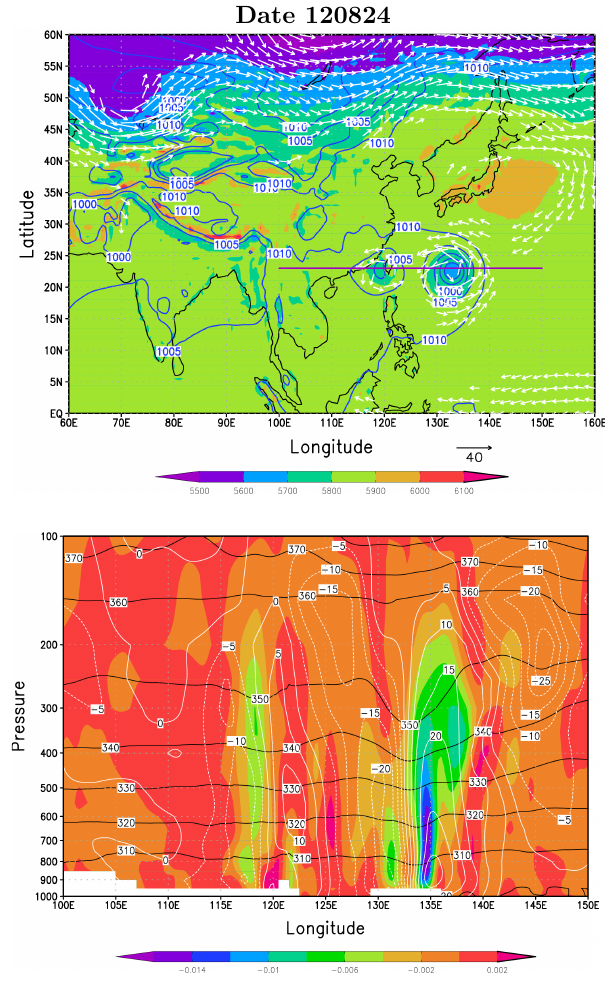
Figure 5. Geopotential height [m] (colour) and horizontal winds [ms − 1 ] (white arrows) at 500hPa on 24 August 2012 taken from ERA-Interim reanalysis data (top). To show the position of the ty- phoons Tembin ( ≈ 23 ◦ N 118 ◦ E) and Bolaven ( ≈ 23 ◦ N 135 ◦ E), the mean sea level pressure [hPa] is shown as blue thick lines. Fig. 5. Geopotential height in [m] (colour) and horizontal winds in [ ms − 1 ] (white arrows) at 500hPa on 24 August 2012 taken from ERA- The thick purple line indicates the position of the longitude–height Interim reanalysis data (top). To show the position of the typhoons Tembin ( 23 ◦ N 118 ◦ E) and Bolaven ( 23 ◦ N 135 ◦ E), the mean sea cross-section shown in Fig. 5 (bottom). Longitude–height cross- ≈ ≈ level pressure in [hPa] is shown as blue thick lines. The thick purple line indicates the position of the longitude-height cross-section shown section showing the typhoon Tembin and Bolaven at 23 ◦ N (bot- in Fig. 5 (bottom). tom). The vertical velocity ( ω ) [hPas − 1 ] (colour), the horizon- Longitude-height cross-section showing the typhoon Tembin and Bolaven at 23 ◦ N (bottom). The vertical velocity ( ω ) in [ hPas − 1 ] (colour), tal winds [ms − 1 ] (white line (positive values) and white dashed the horizontal winds in [ ms − 1 ] (white line (positive values) and white dashed line (negative values)), and potential temperature in Kelvin (black lines) are shown. Very rapid uplift up to 0.014 hPas − 1 is found at the eastern flank of typhoon Bolaven ( line (negative values)), and potential temperature in Kelvin (black 135 ◦ E) and up to − ≈ 0.006 hPas − 1 is found at western flank of typhoon Tembin ( 118 ◦ E). lines) are shown. Very rapid uplift up to − 0.014hPas − 1 is found − ≈ at the eastern flank of typhoon Bolaven ( ≈ 135 ◦ E) and up to − 0.006hPas − 1 is found at the western flank of typhoon Tembin ( ≈ 118 ◦